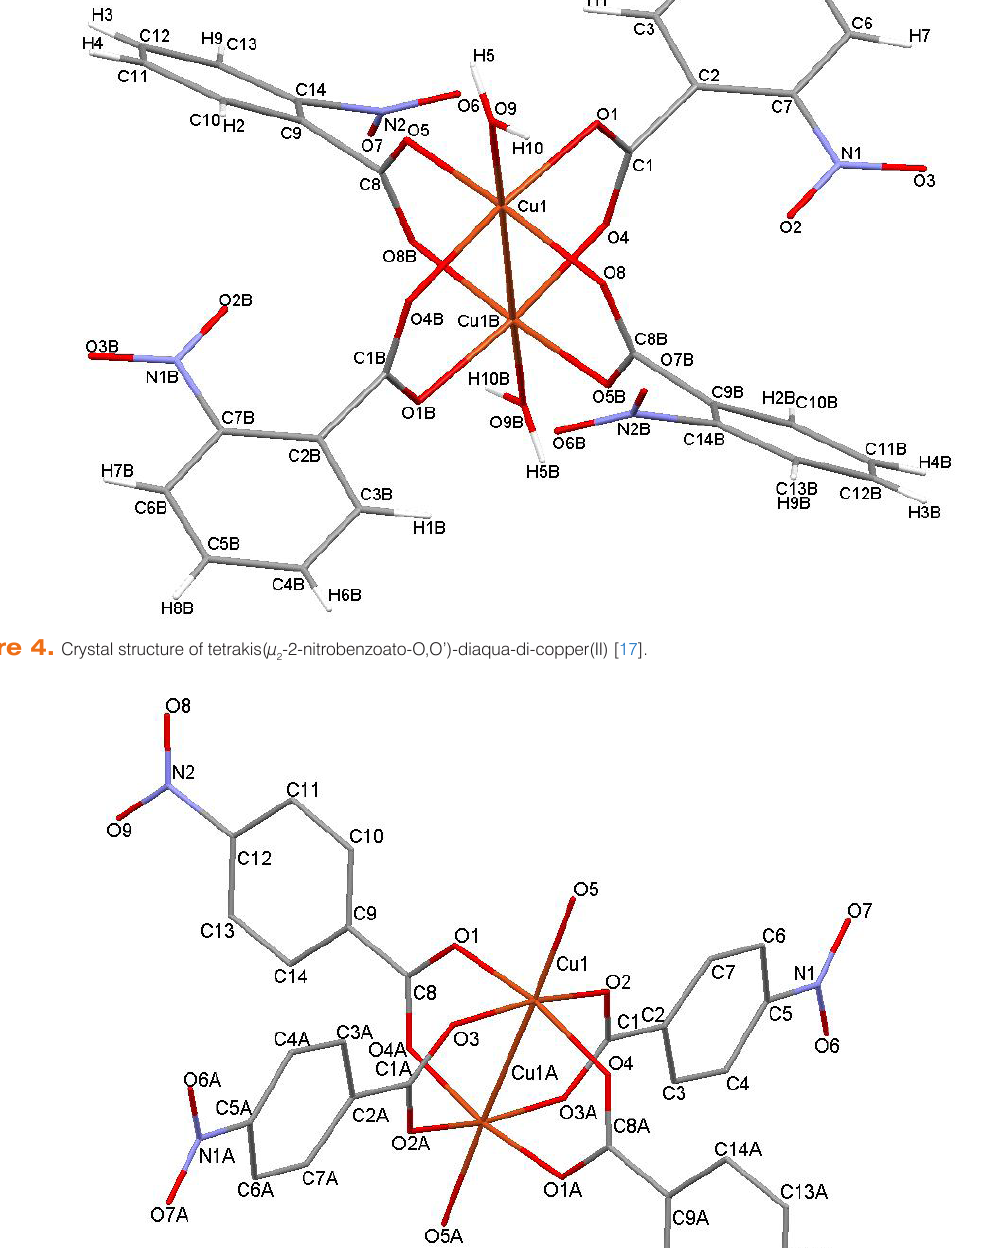
Figure 5. Crystal structure of diaqua-tetrakis(μ